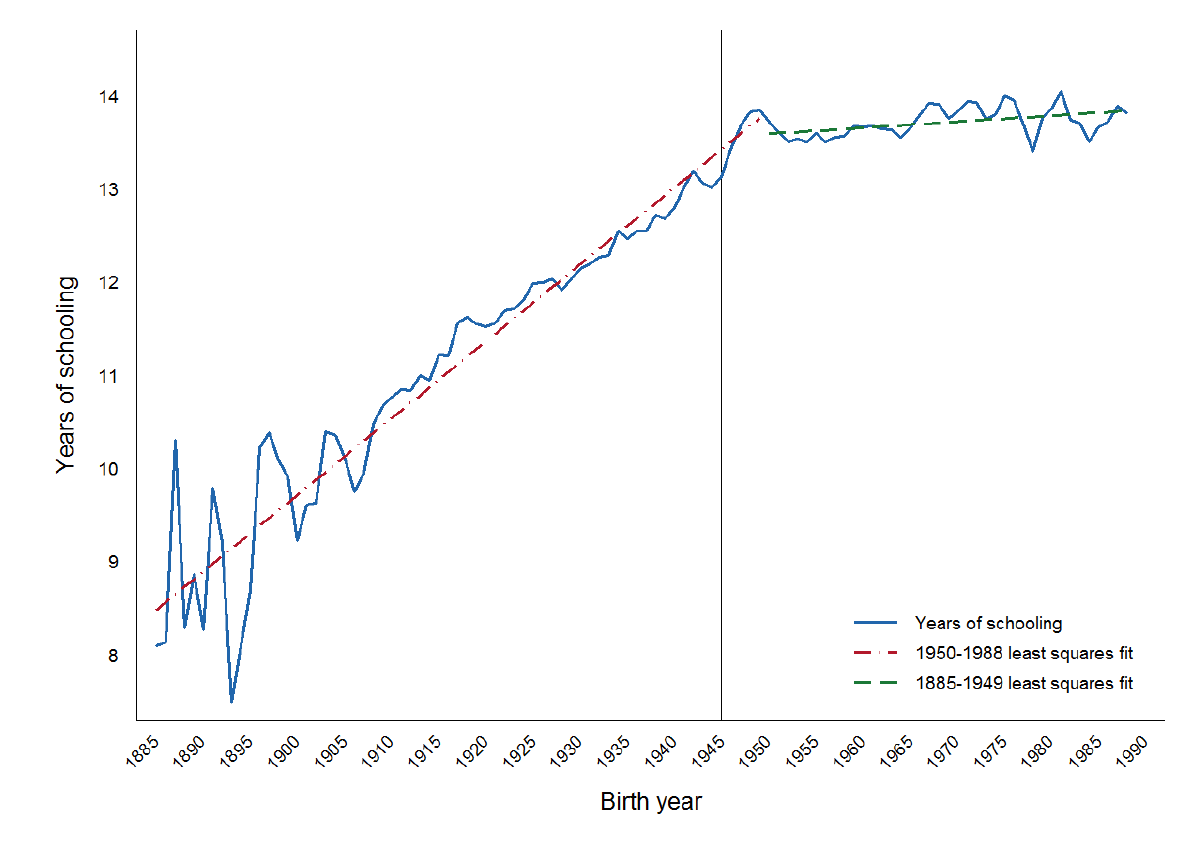
Figure 2: Schooling trends by birth cohort: General Social Survey, 1974–2012. Note: Estimates are sample weighted. A three-year moving average was applied to the schooling trend line. Birth cohort reference category (1946–1950) identified by vertical